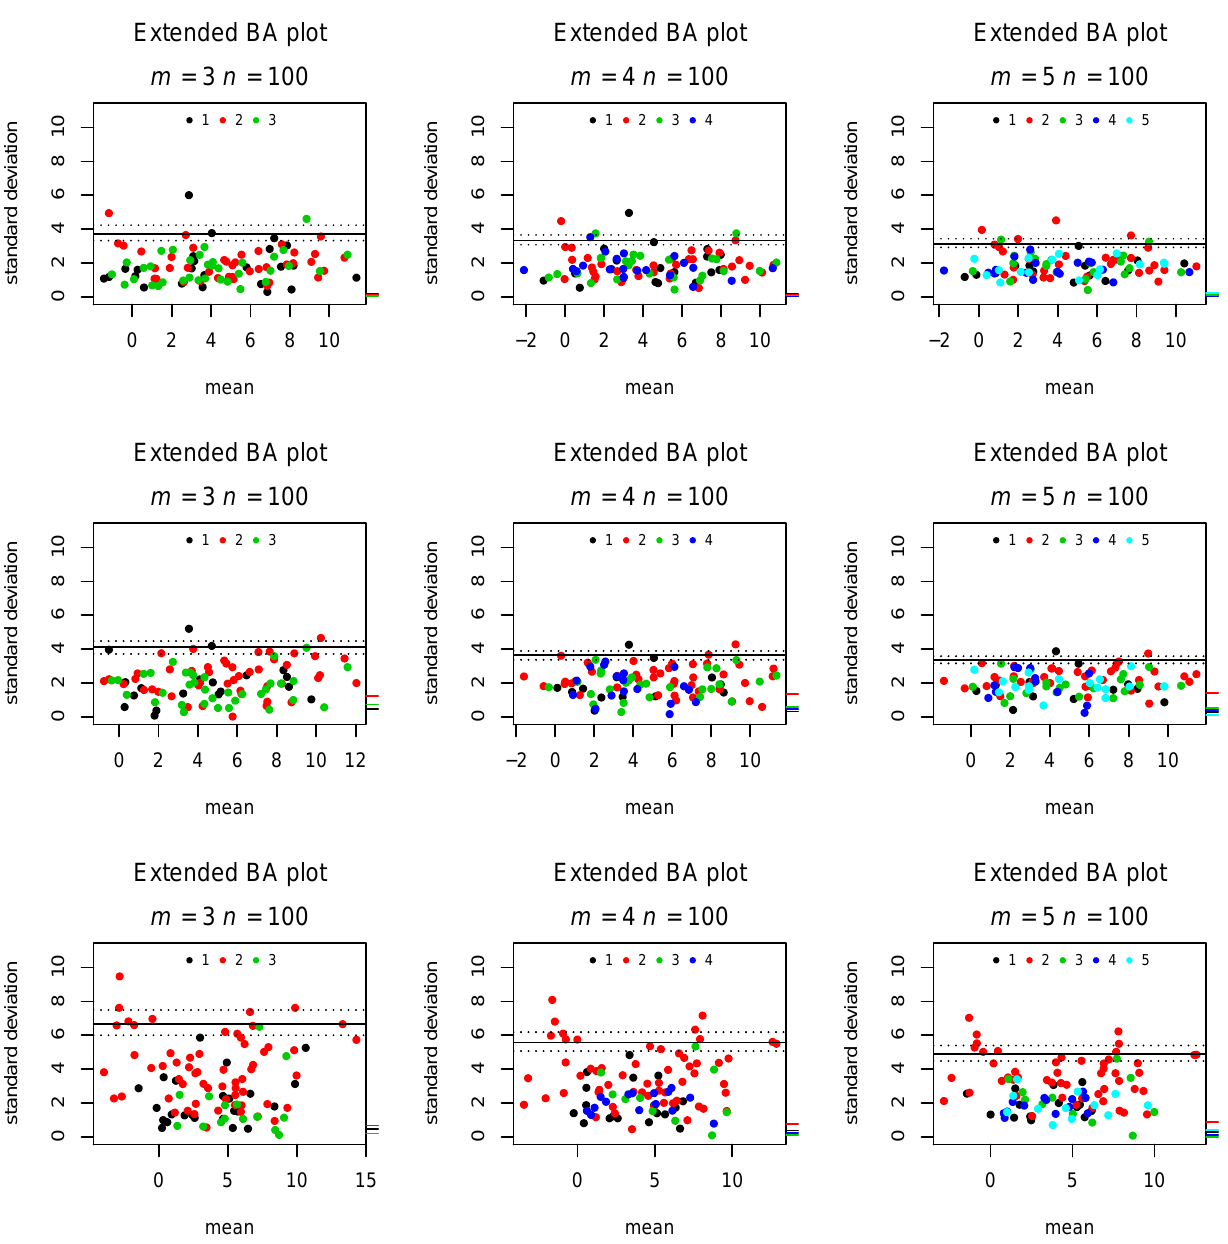
Figure 3. Marking the rater responsible for the largest deviation from the intra-subject mean by colored dots and the absolute rater bias by tick marks on the right y axis. The first row demonstrates absent bias and heterogeneity in error, the second √ row only bias, and the third row only heterogeneity ( σ = 40 for Rater 2 in the third row; all others σ =